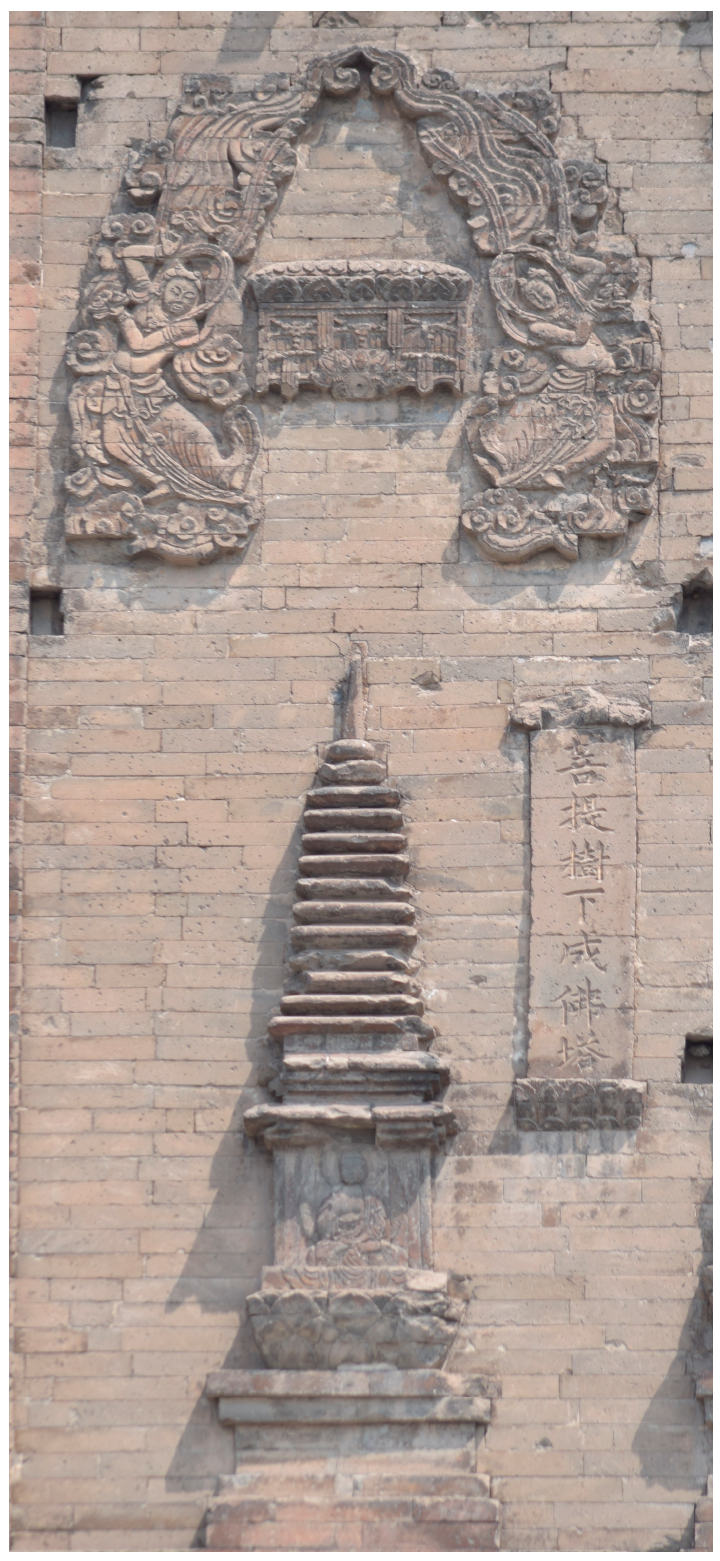
Figure 2. Miniature pagoda, west side of the south wall of Chaoyang North Pagoda. Liao